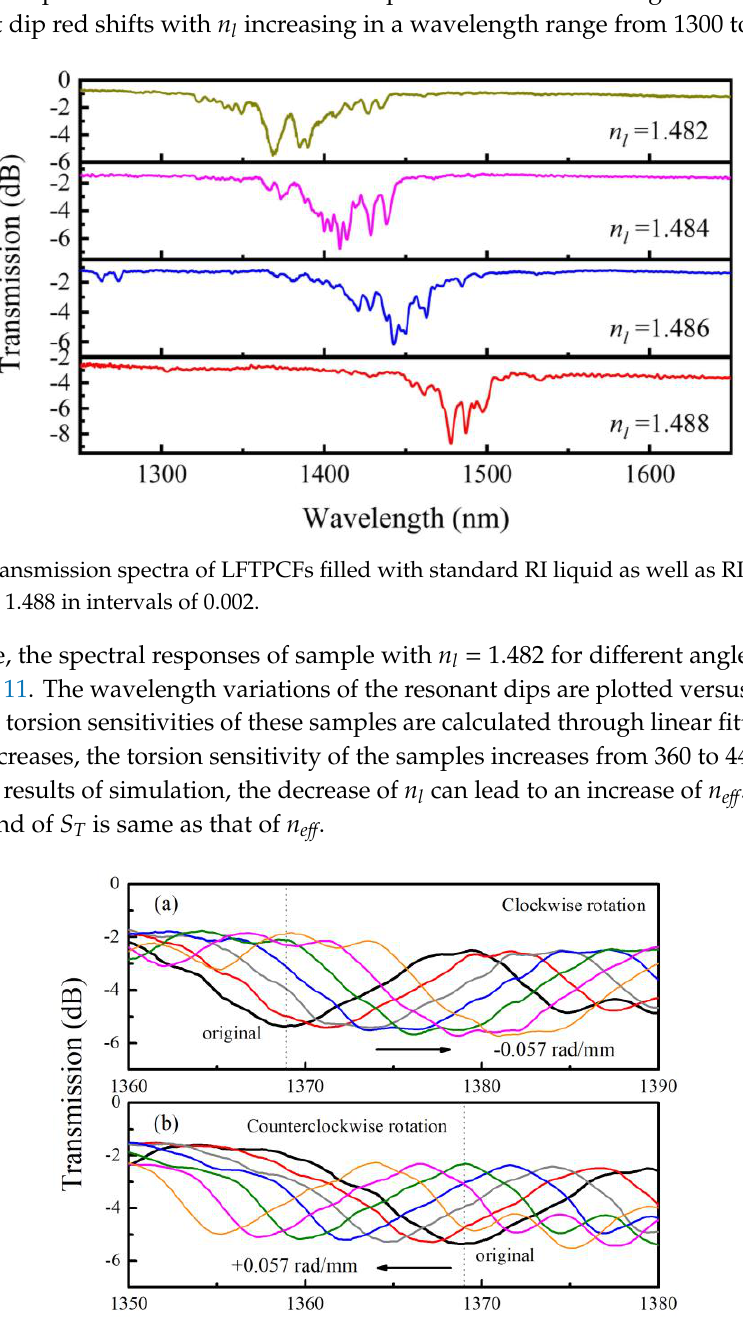
Figure 11. The resonant dip shift of the LFTPCF ( n l = 1.482) under an applied torsion in the range of −0.057 to +0.057 rad/mm in step of 0.0095 rad/mm.